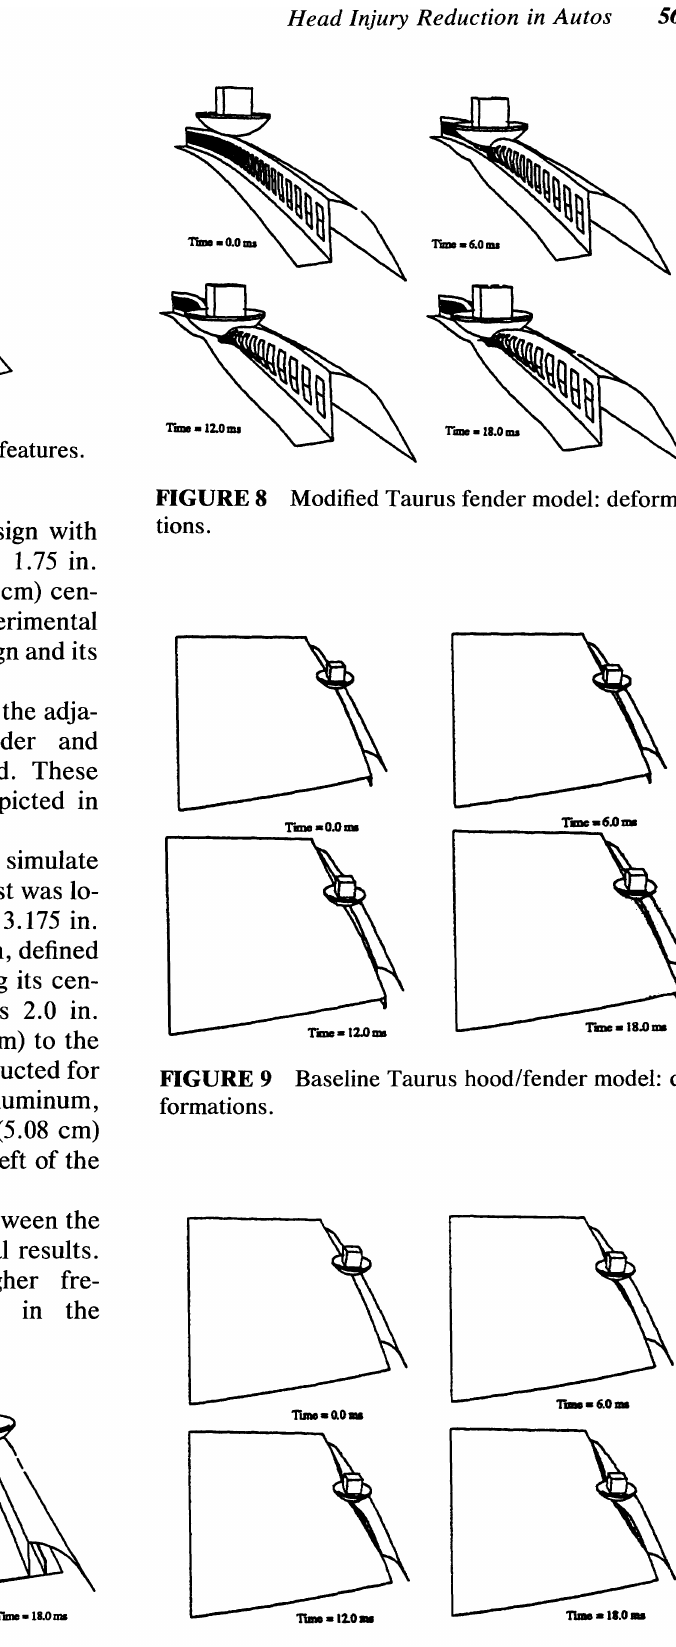
FIGURE 7 Baseline Taurus fender model: deforma tions.